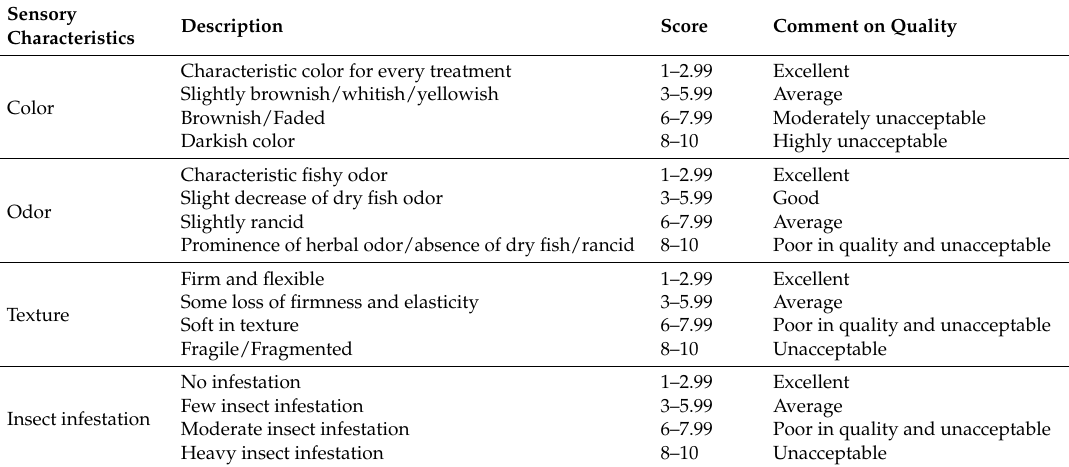
Table 5. Characteristic score for determining the sensory quality of dried